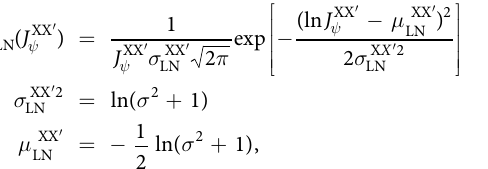
fixed mean 1.0. Figure 1(A) shows an example for σ 2 = 1.0. The probability density function of the sparse-Gaussian distribution is a sum of a delta function and a truncated Gaussian function peaked at 0: